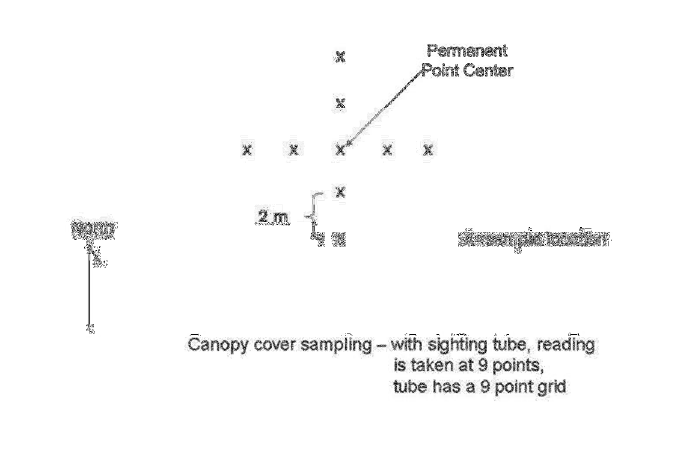
Figure 3 . Canopy Cover Sampling Diagram for the Permanent Point Centers (8 Point Centers per Fire